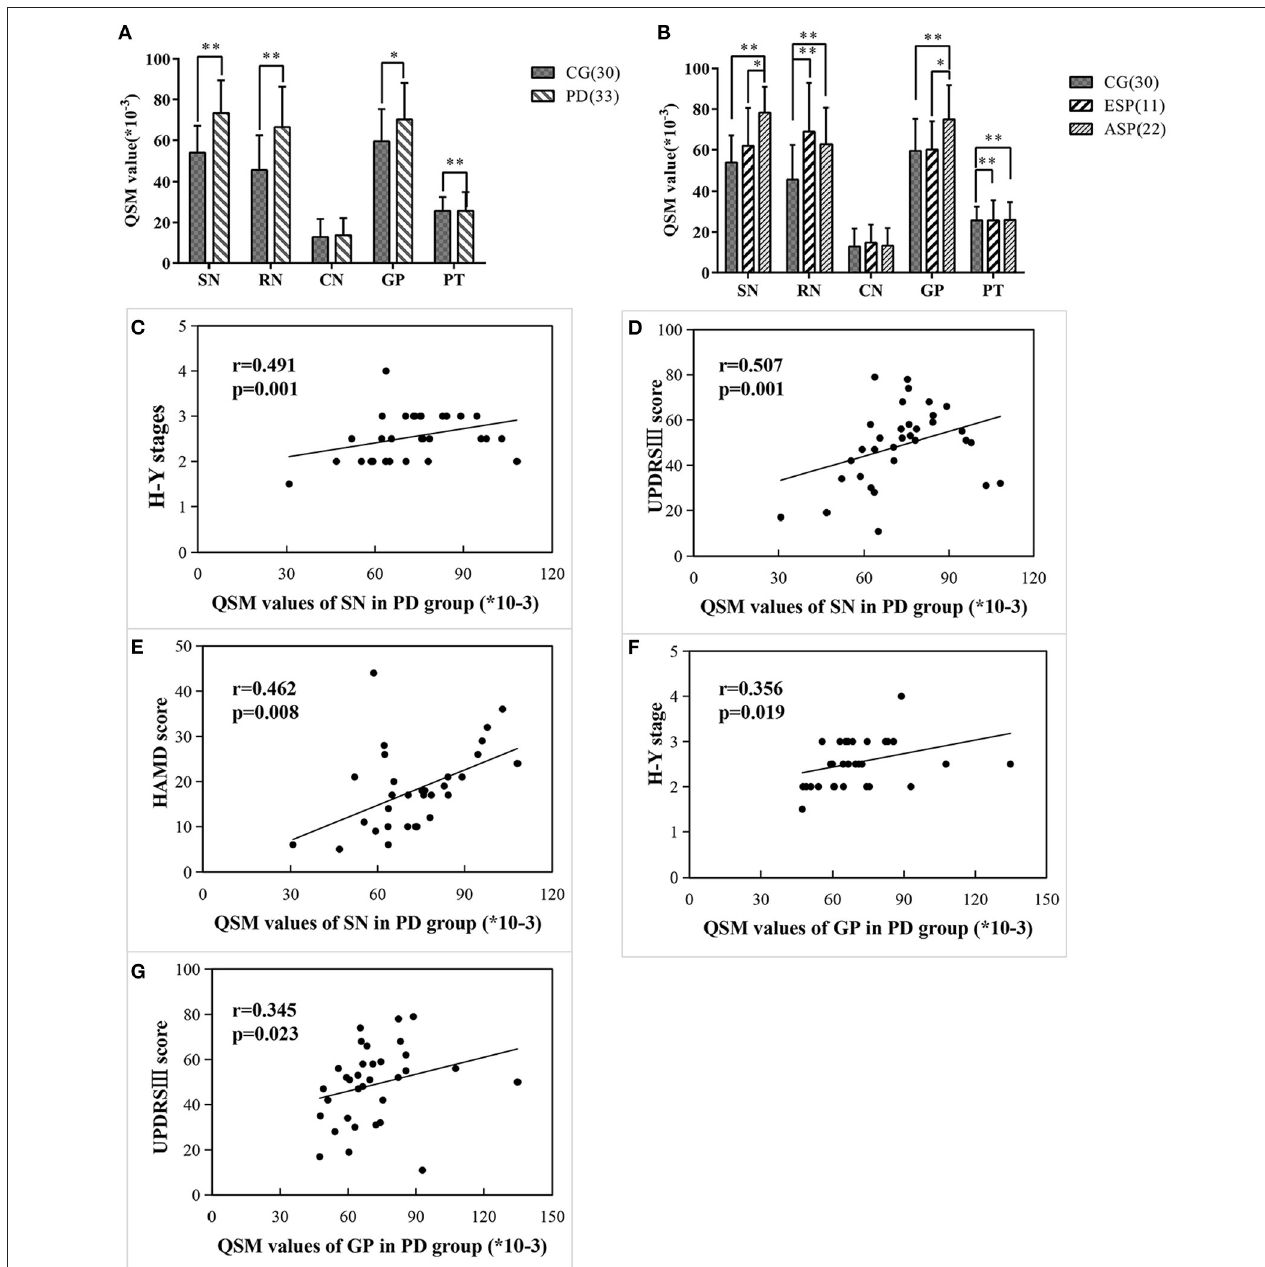
FIGURE 2 | Comparisons of regional QSM values between different groups/subgroups and the correlations between regional QSM values and clinical data in PD cases. (A,B) Differences of regional QSM values between the CG and PD group (A) and CG and two subgroups (B) using covariance analysis adjusted for age. Significant differences are represented as: * p < 0.05, ** p < 0.01. (C–E) QSM values of SN significantly correlated with H-Y stage (C) , UPDRSIII score (D) , and HAMD score (E) in PD patients. (F,G) QSM values of GP significantly correlated with H-Y stage (F) , UPDRSIII score (G) in PD